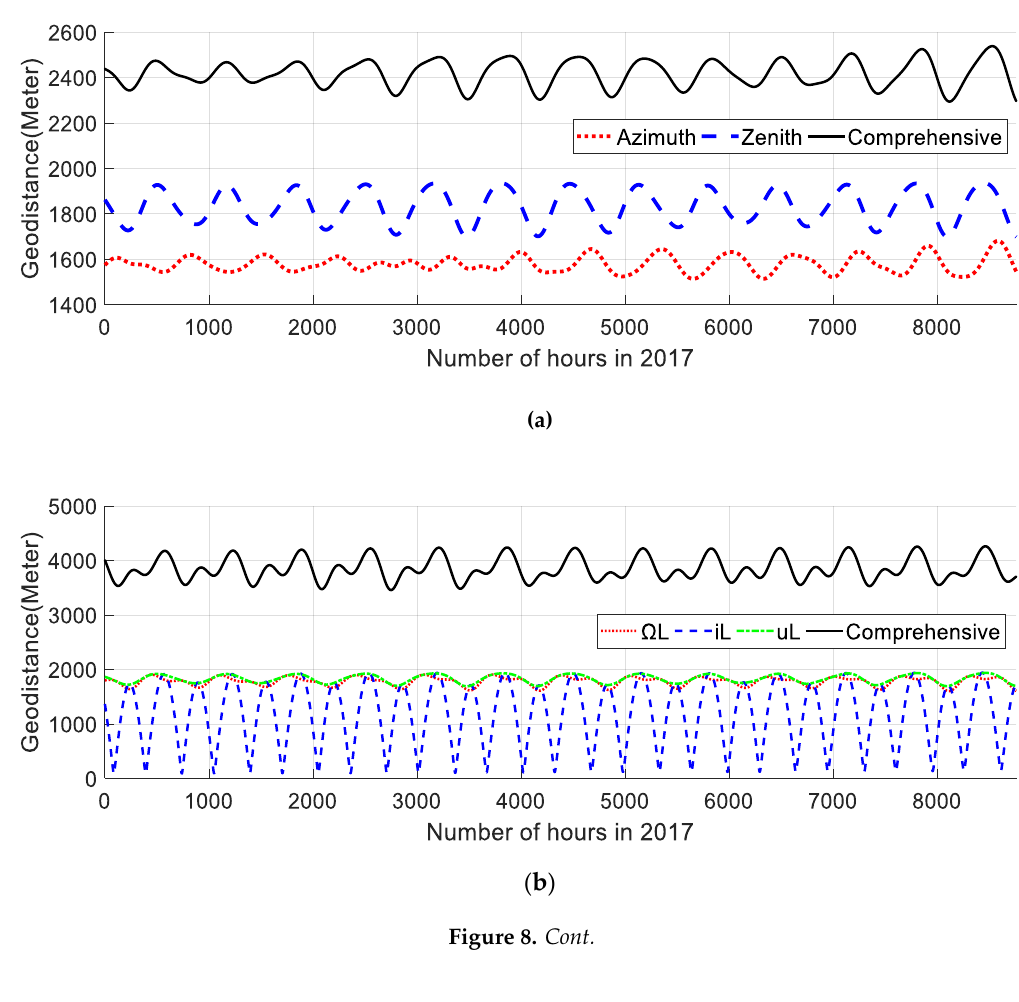
Figure 7. Aberration and light time effects.